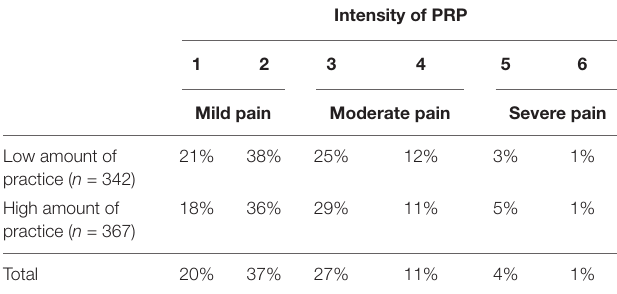
TABLE 9 | Intensity of reported pain ( N =